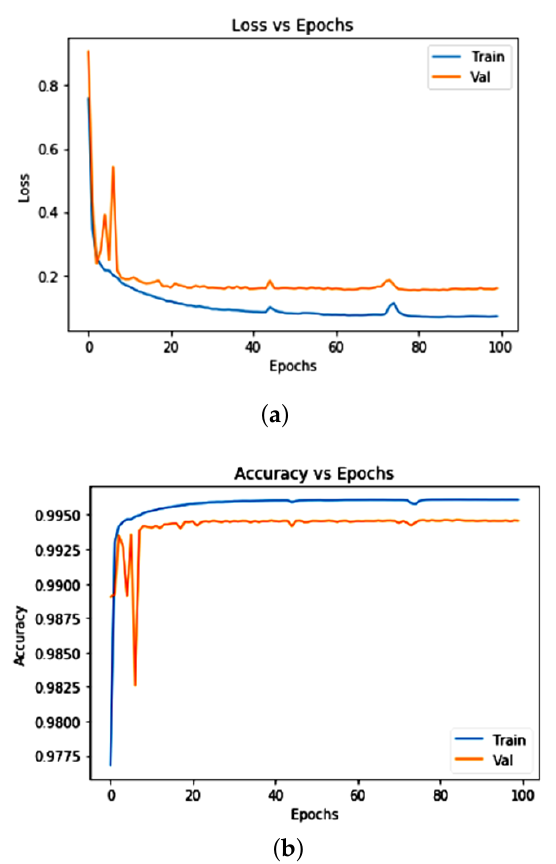
Figure 5. ( a ) Loss curve during the validation and training process. ( b ) Accuracy curve during the validation and training process for training. The lines (validation (orange) and training (blue)) were estimated using binary cross-entropy dice loss and represent the weight loss across all